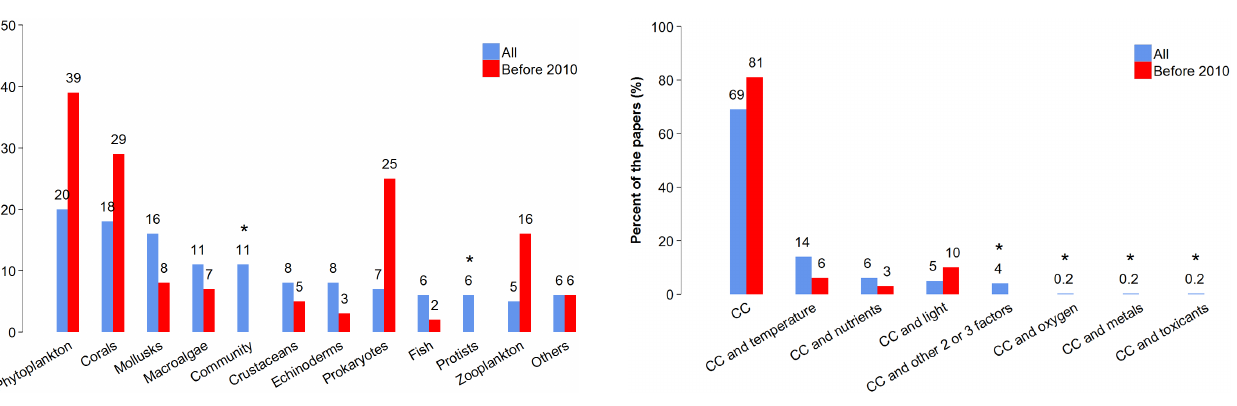
Figure 5. Papers that have manipulated the carbonate chemistry alone and those that have manipulated the carbonate chemistry as well as other variables. CC, carbonate chemistry. The categories marked with * were not present in Nisumaa et al.